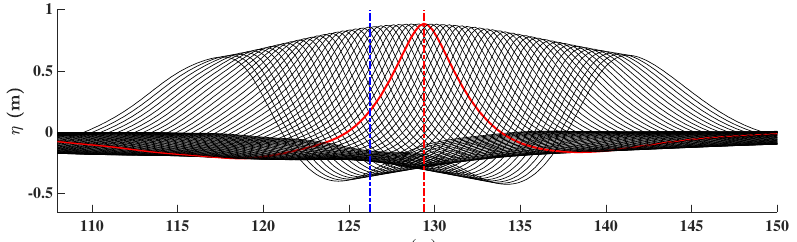
Figure 7. Wave profiles along the longitudinal direction of the wave tank are plotted in one graph at an interval of 0.06 s near t = 103.0 s. The red dash-dot line indicates the real focusing location in the NWT at x = 129.38 m. The blue dash-dot line indicates the designated focusing location at x = 126.21 m.